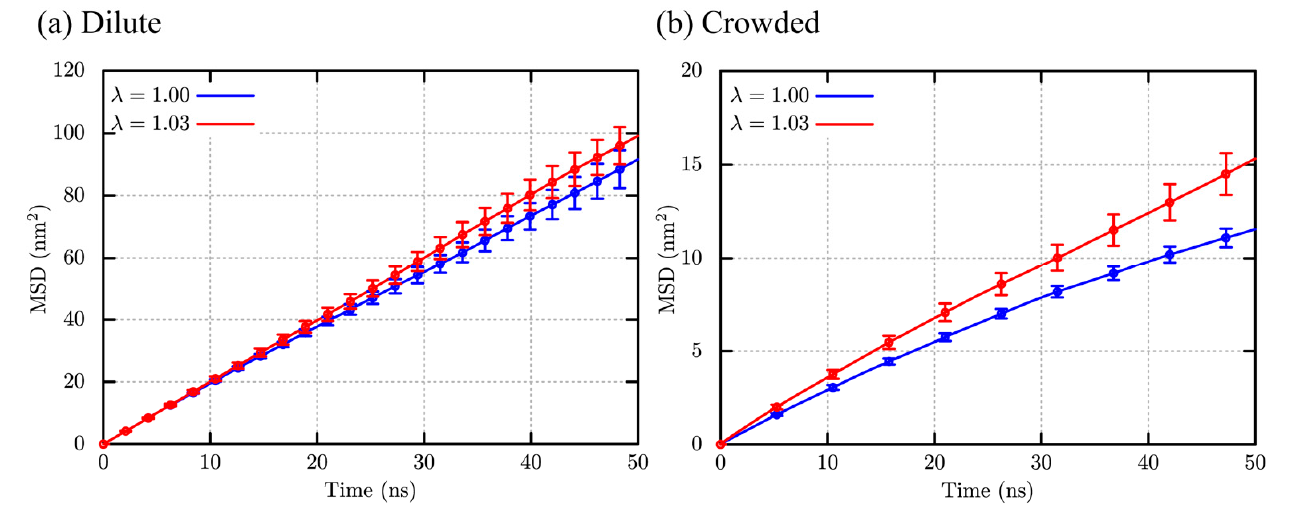
Figure 7. Mean square displacements (MSDs) of villin in ( a ) the dilute and ( b ) crowder